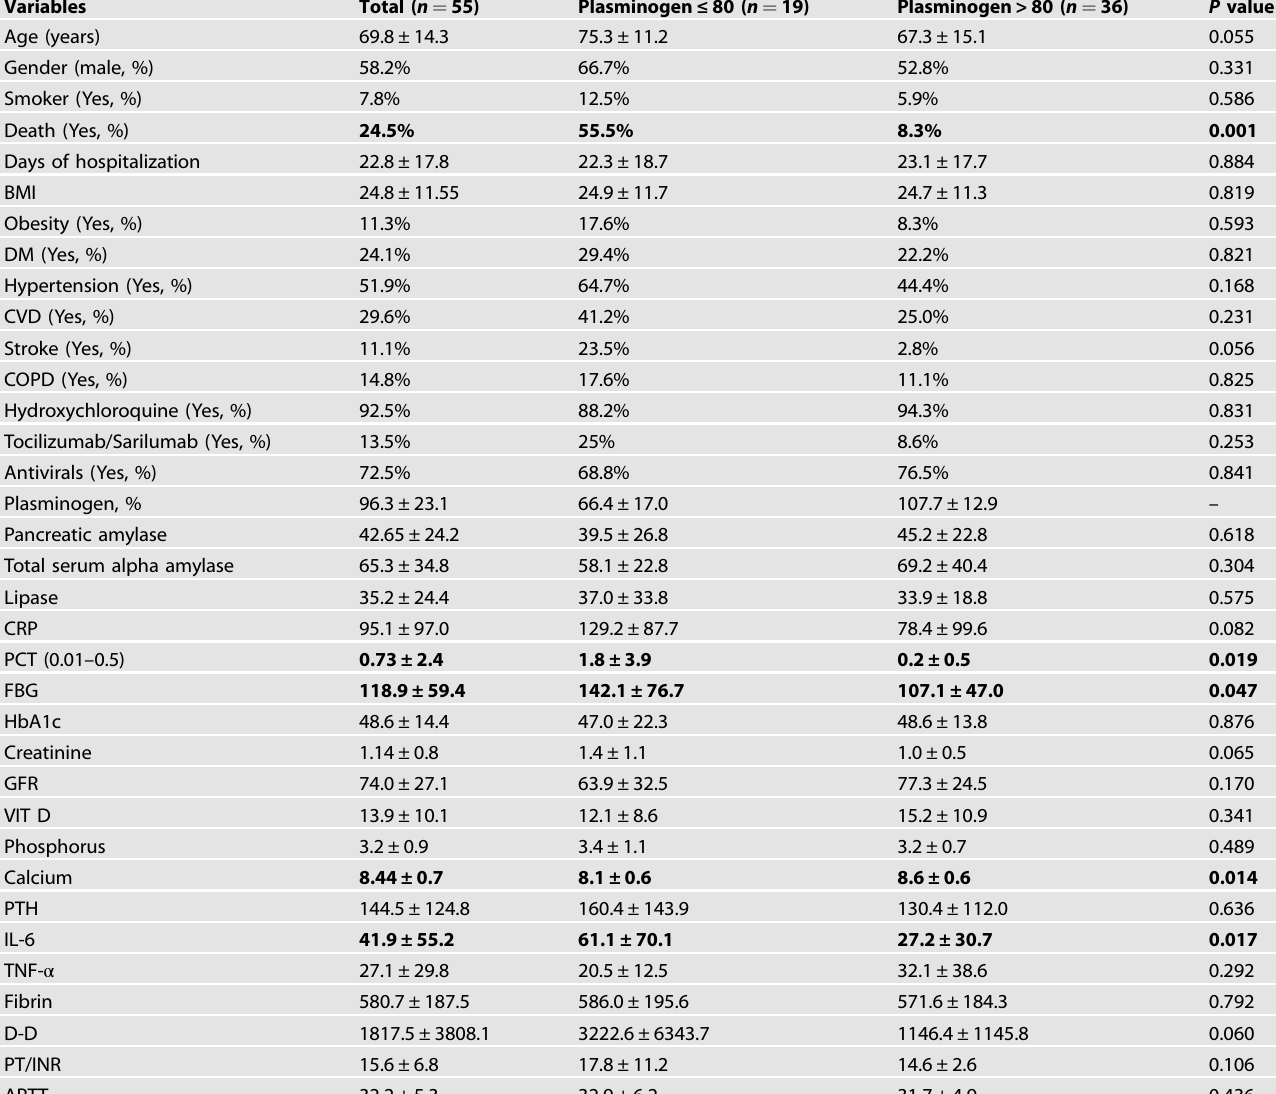
Table 1. Demographic and clinical characteristics of the study population by level of